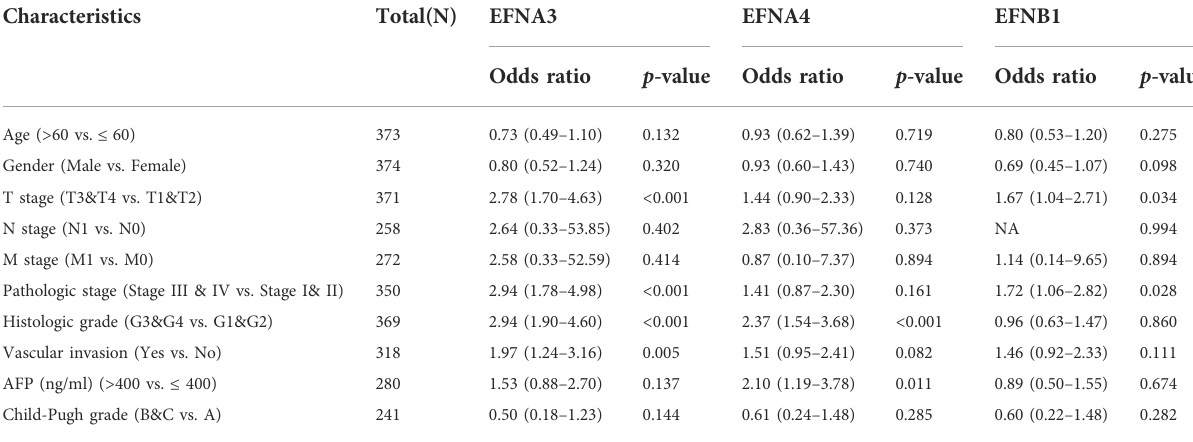
TABLE 2 The correlation between prognosis-related ephrin genes expression and clinicopathology characteristics.